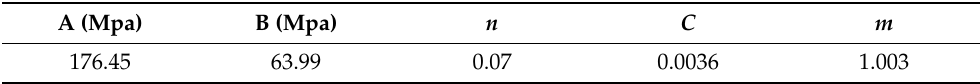
Table 1. Parameters of Johnson-Cook model for 6063 aluminum